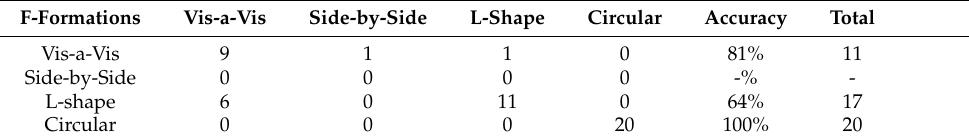
Table 10. Estimating F-formations in Scene 1: confusion matrix and accuracy.